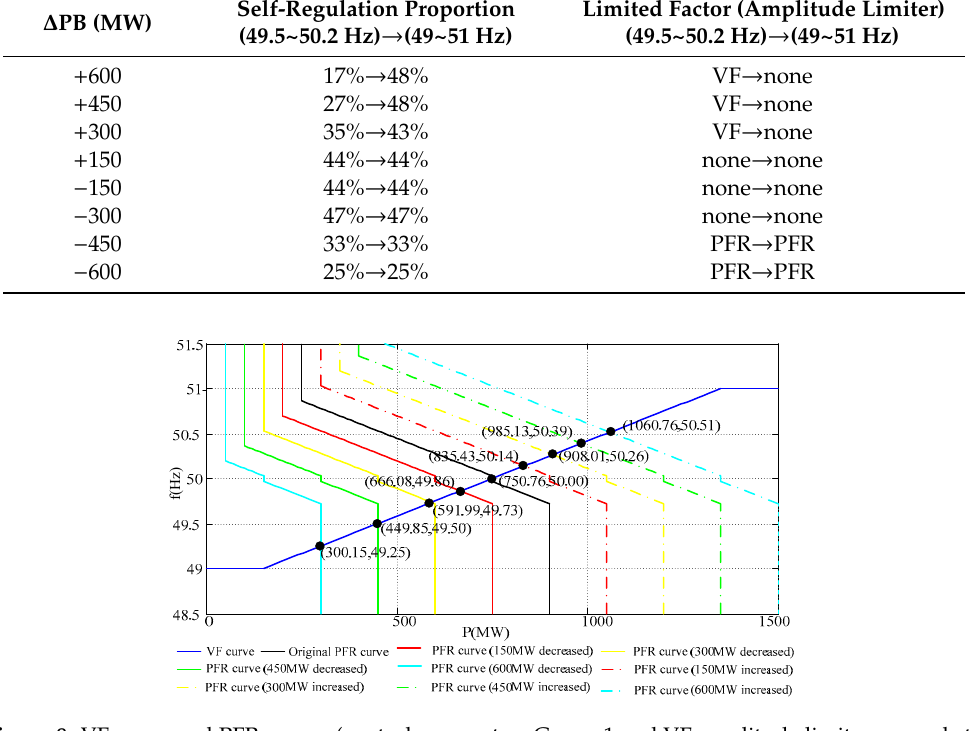
Figure 8. VF curve and PFR curves (control parameters Group 1 and VF amplitude limiter expands to 49~51 Hz).